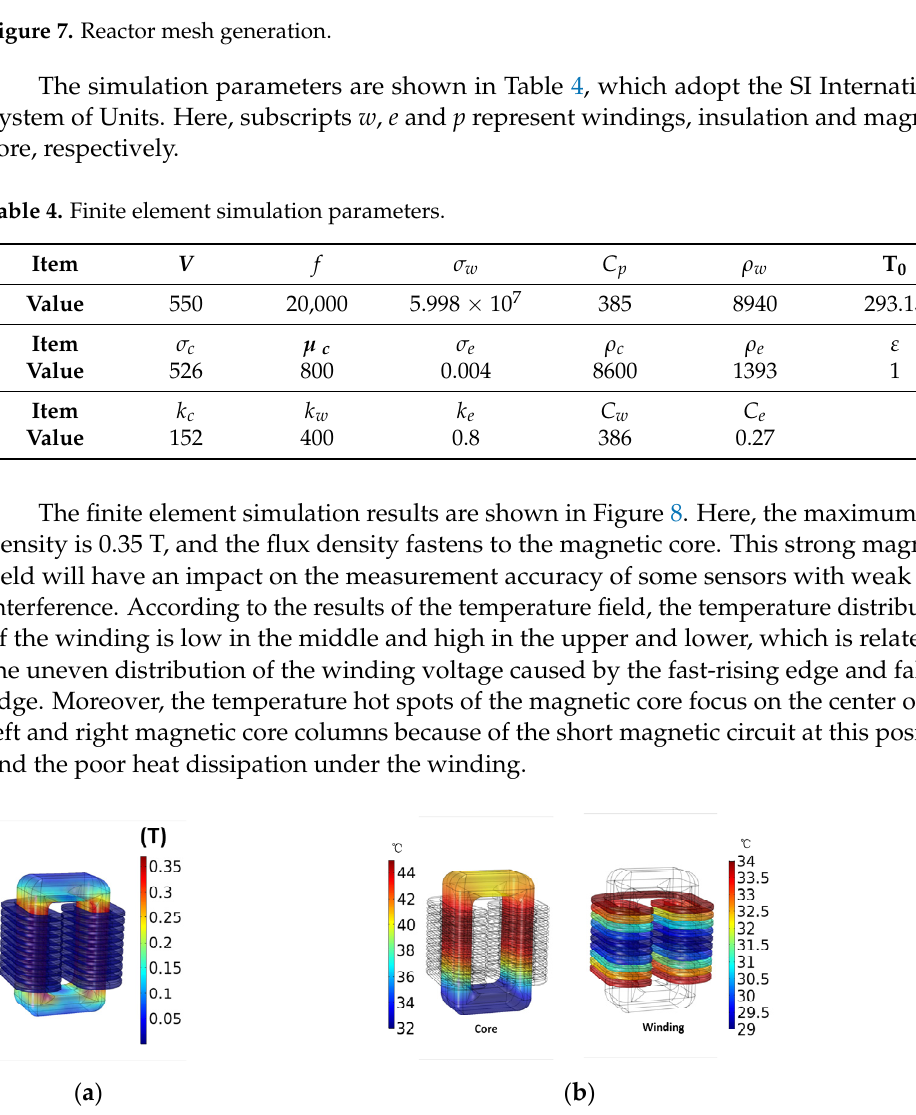
Figure 8. ( a ) Simulation results of electromagnetic field; ( b ) Simulation results of temperature field.